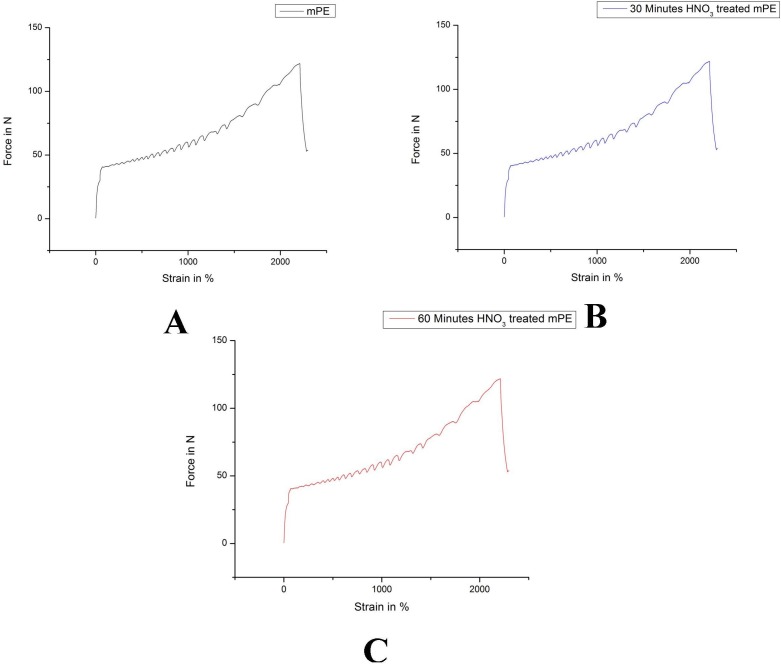
Representative tensile testing result of untreated and HNO3 treated mPE.(A) Untreated mPE (B) 30 min HNO3 treated mPE (C) 60 min HNO3 treated mPE.